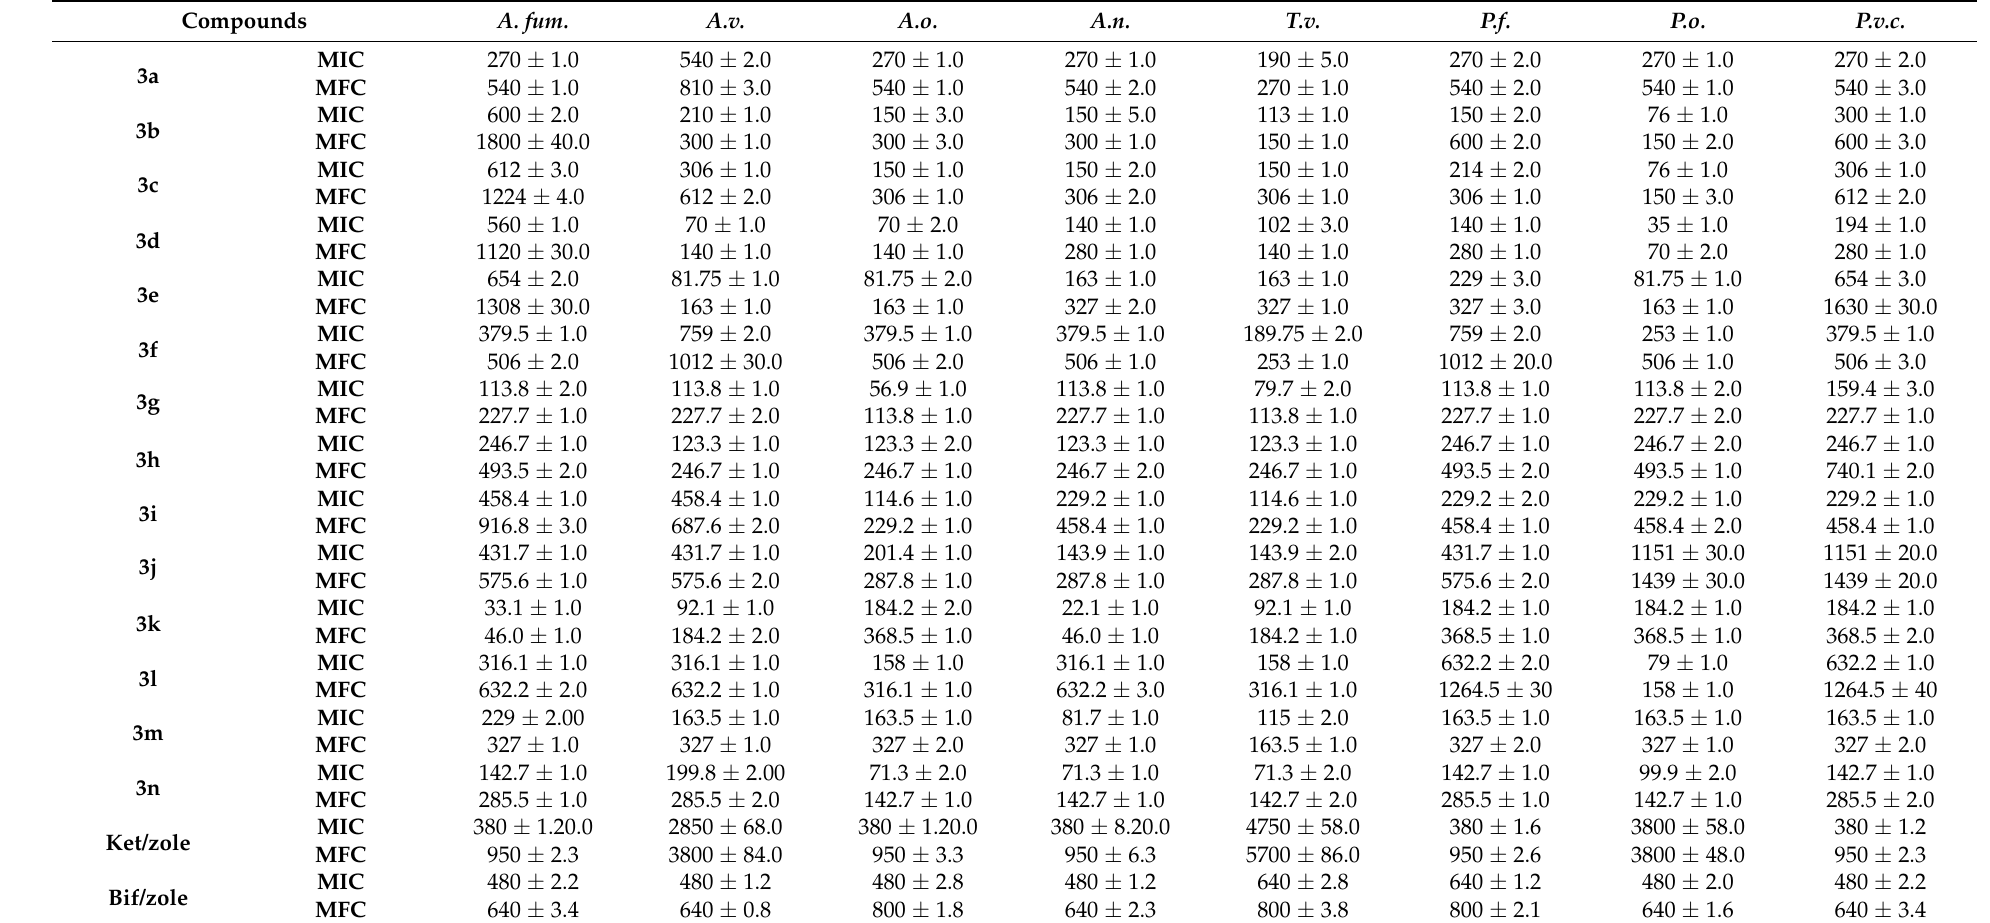
Table 2. Antifungal activity of the tested compounds ( µ